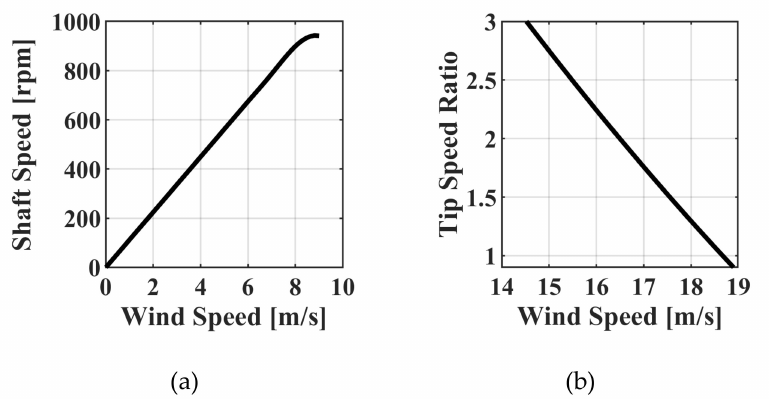
Figure 6. Look-up tables ( LUT )s of the control algorithm. ( a ) Shaft speed reference during MPPT control. ( b ) Tip-speed ratio (TSR), during constant torque control (CTC).